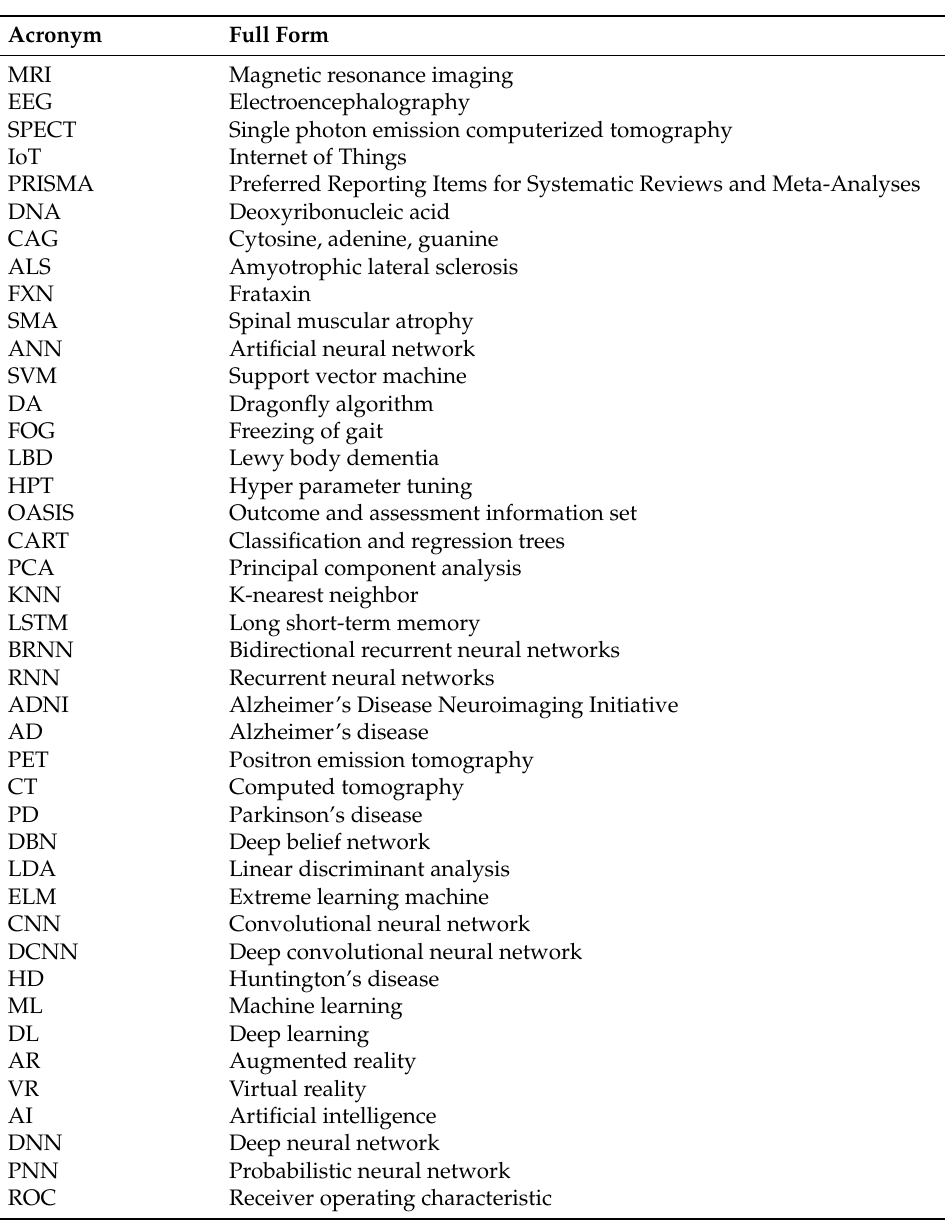
Table A1. List of Glossary/Nomenclature/Abbreviations used in the manuscript and their